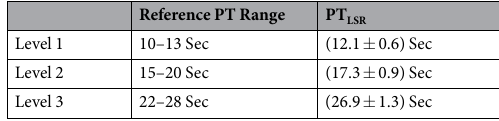
Table 1. Quality assessment test for LSR sensor.